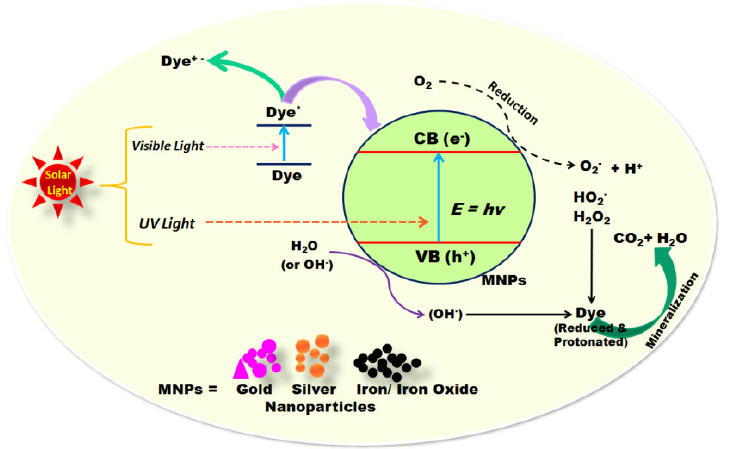
Figure 8. Possible mechanism for the photocatalytic degradation of different dyes using nanoparticles. Copied from MDPI [163].